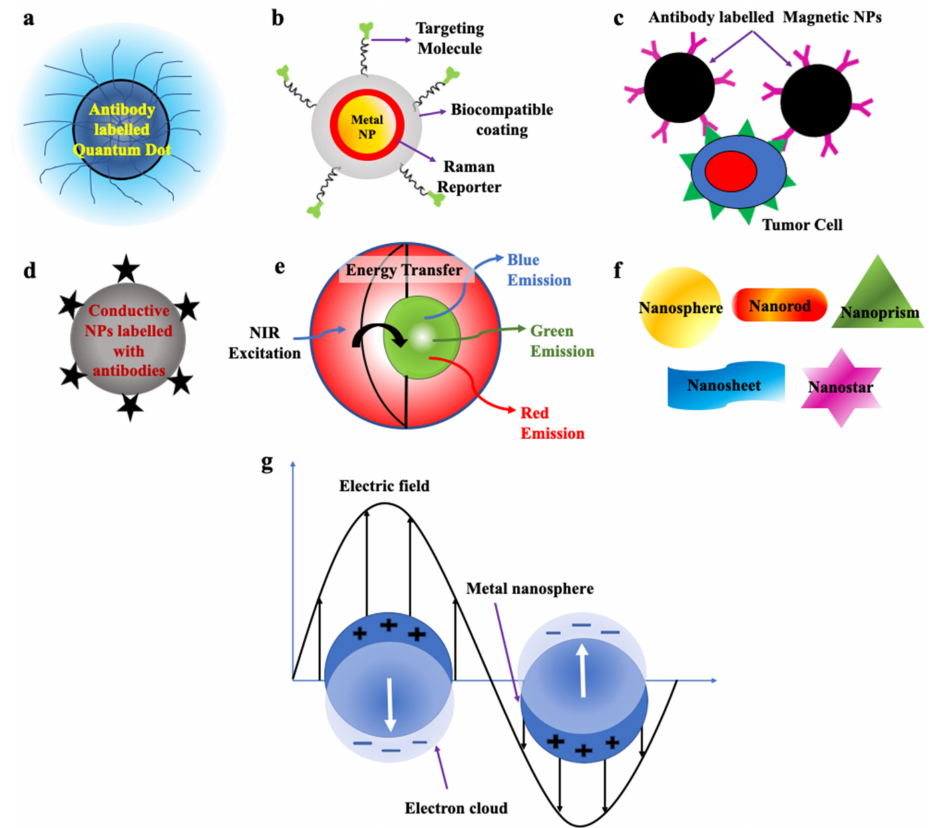
Figure 3. Schematic representation of ( a ) Quantum dot labelled with antibodies (Redrawn after [72]). ( b ) SERS nanoparticles (Redrawn after [73]). ( c ) Magnetic Nanoparticles labelled with antibodies (Redrawn after [62]). ( d ) Conductive nanoparticles. ( e ) Upconversion nanoparticles (Redrawn after [74]). ( f ) Nanoparticles of various morphologies used to detect CTCs. ( g ) Metallic nanoparticle displaying surface plasmon resonance (Redrawn after